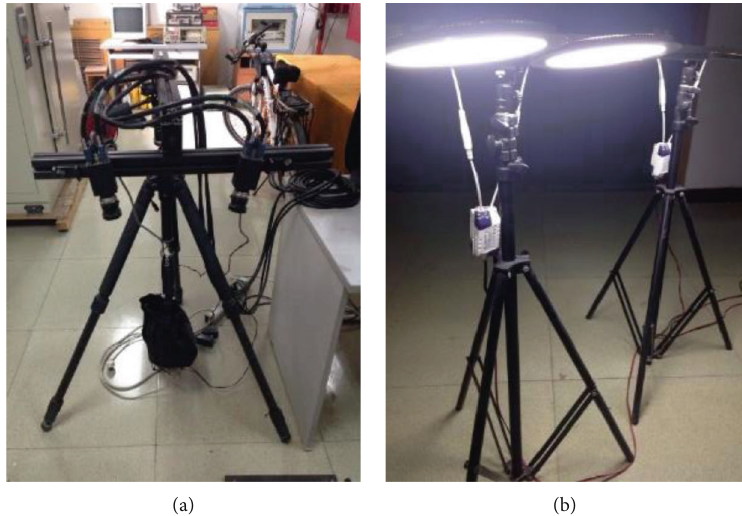
Figure 2: DIC system: (a) high-speed cameras and (b) light sources.